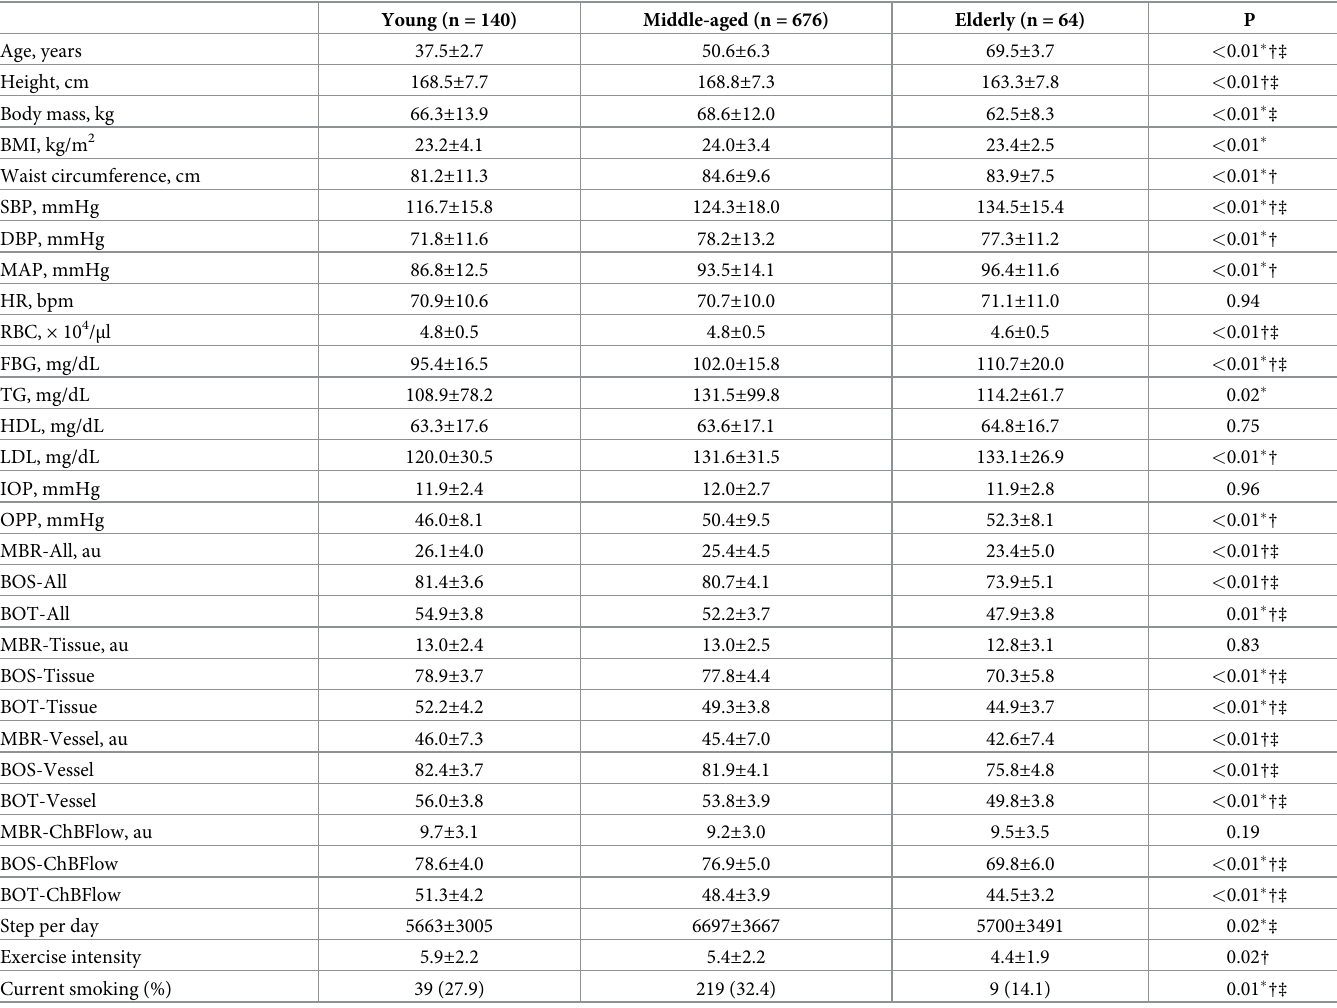
Table 1. Characteristics in the three age